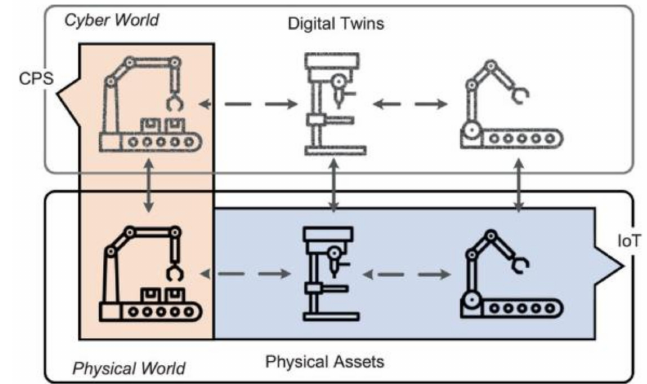
Figure 1. Relationship between CPS, DT, and IoT